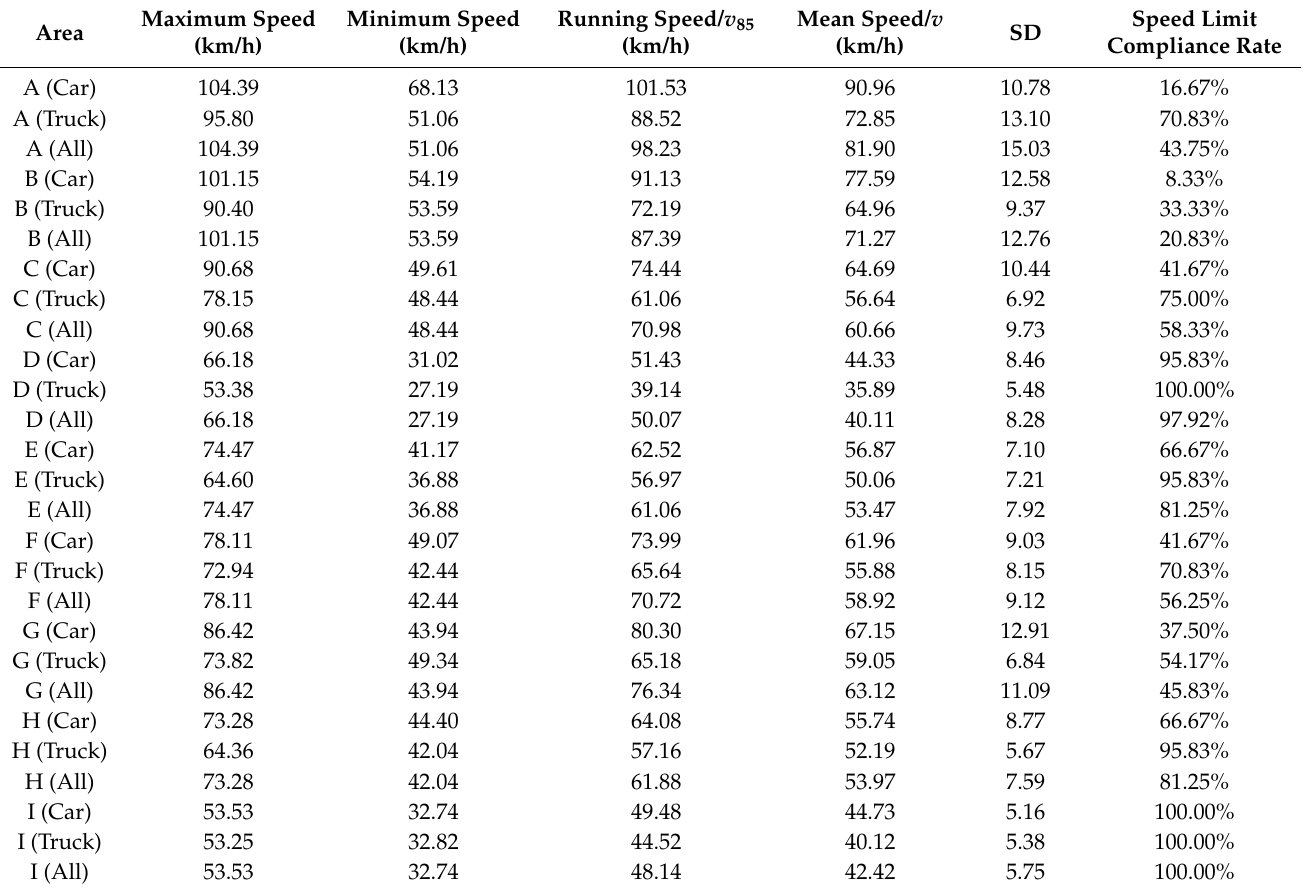
Table 4. Results of vehicle speed statistics for different areas and